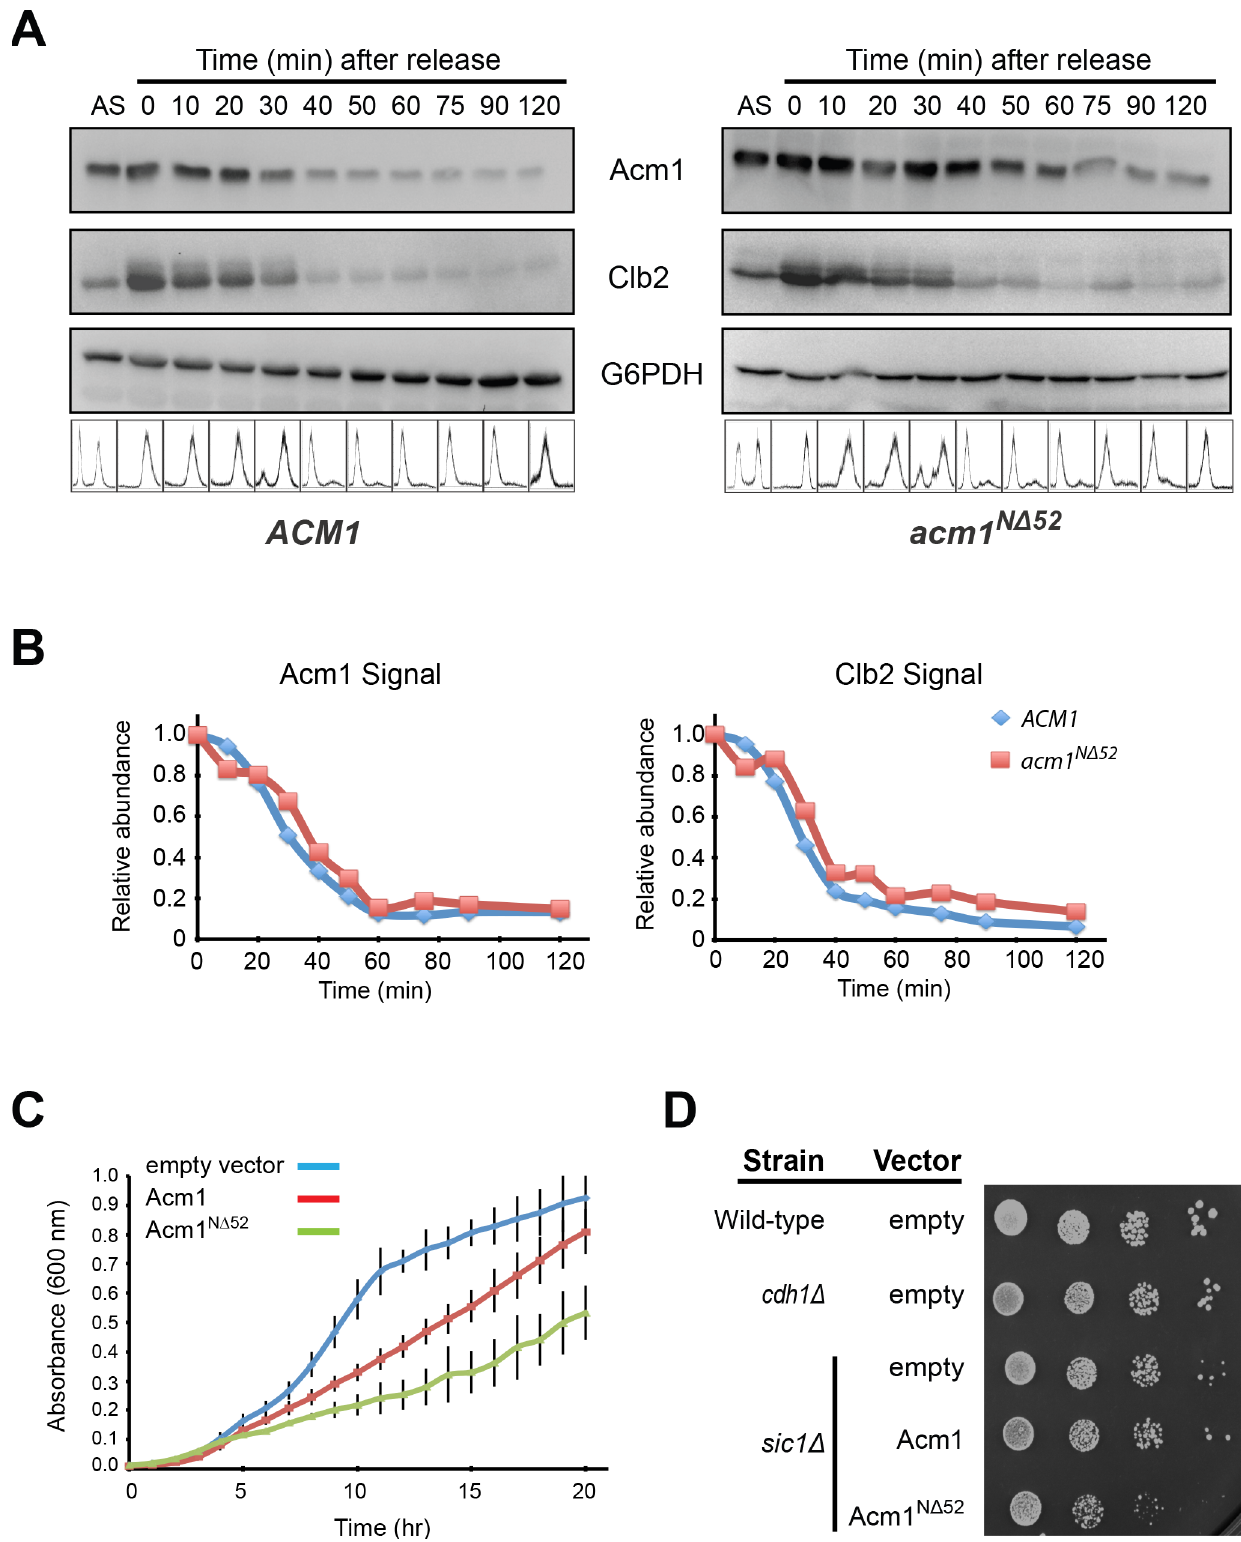
Figure 7. Acm1 N D 52 is still cleared at mitotic exit, but constitutive expression impairs growth of sic1 D cells. A) YKA859 cells carrying either pHLP117 (for expression of 3HA-Acm1) or pHLP505 (for expression of Acm1 N D 52 -ProtA) were arrested at metaphase by methionine repression of P MET3 -CDC20 and then released in the absence of methionine. Cells were collected at regular intervals and analyzed by immunoblotting using antibodies against Acm1, Clb2, or G6PD (loading control). B) Quantitation of chemiluminescent immunoblots from panel A. Data are the average of 4 independent experiments. C) Growth of sic1 D cells transformed with either an empty vector, pHLP361 ( P ADH - Acm1-ProtA ) or pHLP363 ( P ADH - acm1 N D 52 -